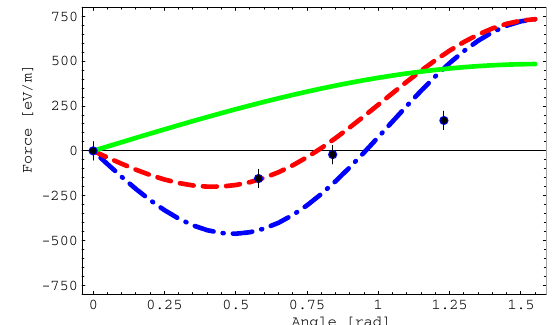
FIG. 6. (Color) Transverse component of the force. Comparison (cid:5) 1 : 1 (cid:6) 10 7 m = s : blue dot-dashed line—Eq. (6); red for (cid:1) e; ? dashed line—Eq. (8); green solid line—Eq. (9); dots with error bars— VORPAL